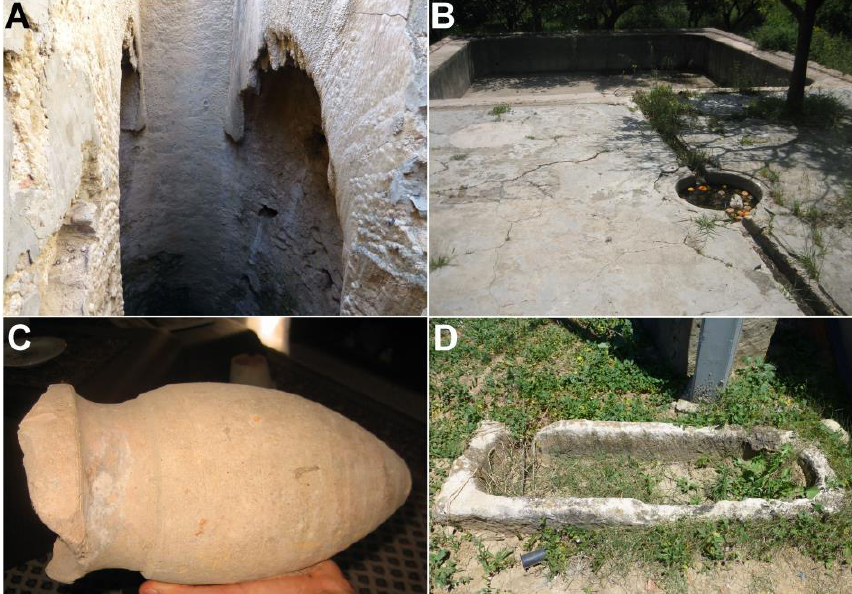
Figure 11. Elements of a waterwheel system at Testour: ( A ) Interior of a well that housed a waterwheel; note the circular shape of the well, the lining of the walls, and the two parallel arches that formed the base of the waterwheel. ( B ) Collection basin, with its decanter, through which the irrigation channel carrying the water from the waterwheel passed. ( C ) Earthenware ‘ arcaduz ’ buckets found at the bottom of an abandoned well. ( D ) Trough- abrevadero . Source: Author. The wells are circular, about five metres in diameter, and 15–20 m deep. The inner walls are lined with stone blocks bound together with mortar. Most of these wells are covered with two parallel semi-circular arches that leave a rectangular shaped hollow be-